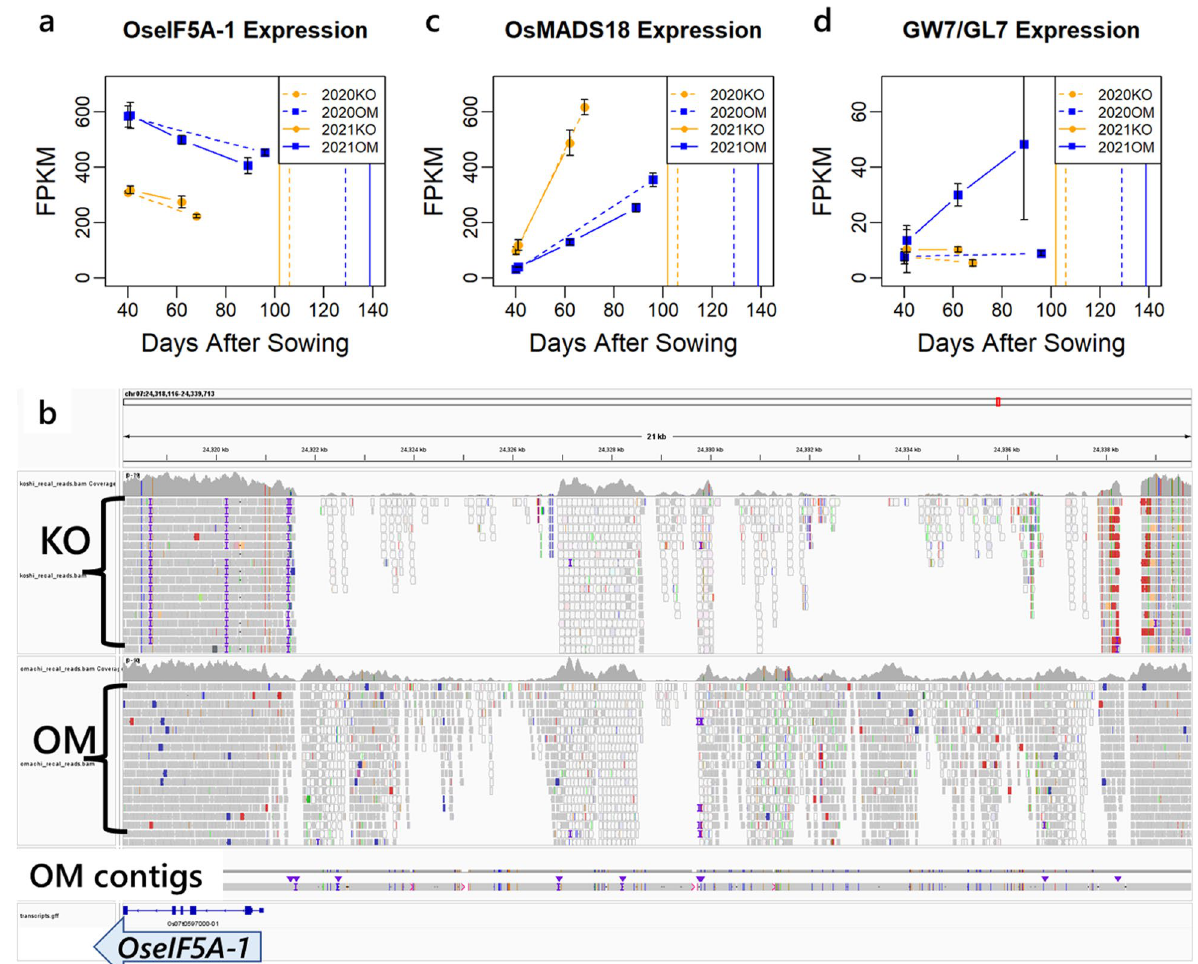
Fig. 6 DEGs within the qCD7-2 region. a Expression levels of OseIF-5A . Orange and blue lines indicate the expression levels in Koshihikari and Omachi, respectively. Dashed and solid lines indicate the expression levels in 2020 and 2021, respectively. b Mapping status of next generation sequence reads upstream of the OseIF5A-1 gene coding region, visualized by Integrative Genomics Viewer (IGV). Top row: Koshihikari short reads, middle row: Omachi short reads, bottom row: contig composed of Nanopore long reads of Omachi. c Expression levels of OsMADS18 . d Expression levels of GW7 /